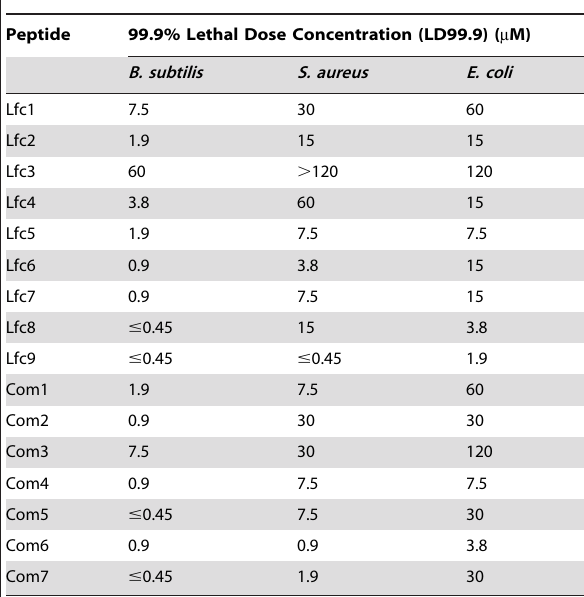
Table 2. Fragments identified by MALDI-MS from 75 min peptide incubations in diluted human serum at 37 u C a .